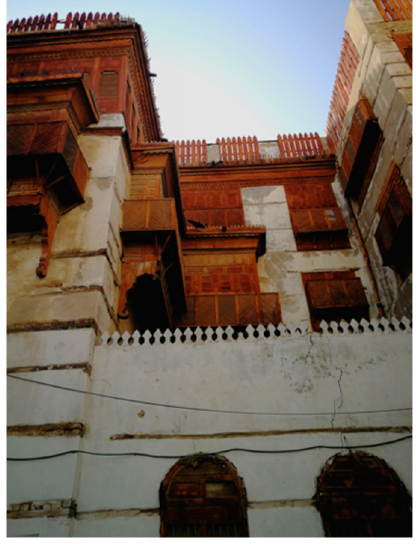
Figure 2. Historic buildings: ( a ) Baeshen House and ( b ) Zainal House.